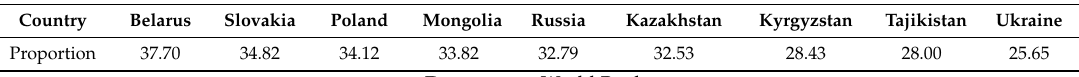
Table 1. Proportion of the secondary industry of the main China-Europe Railway Express countries along “the Belt and